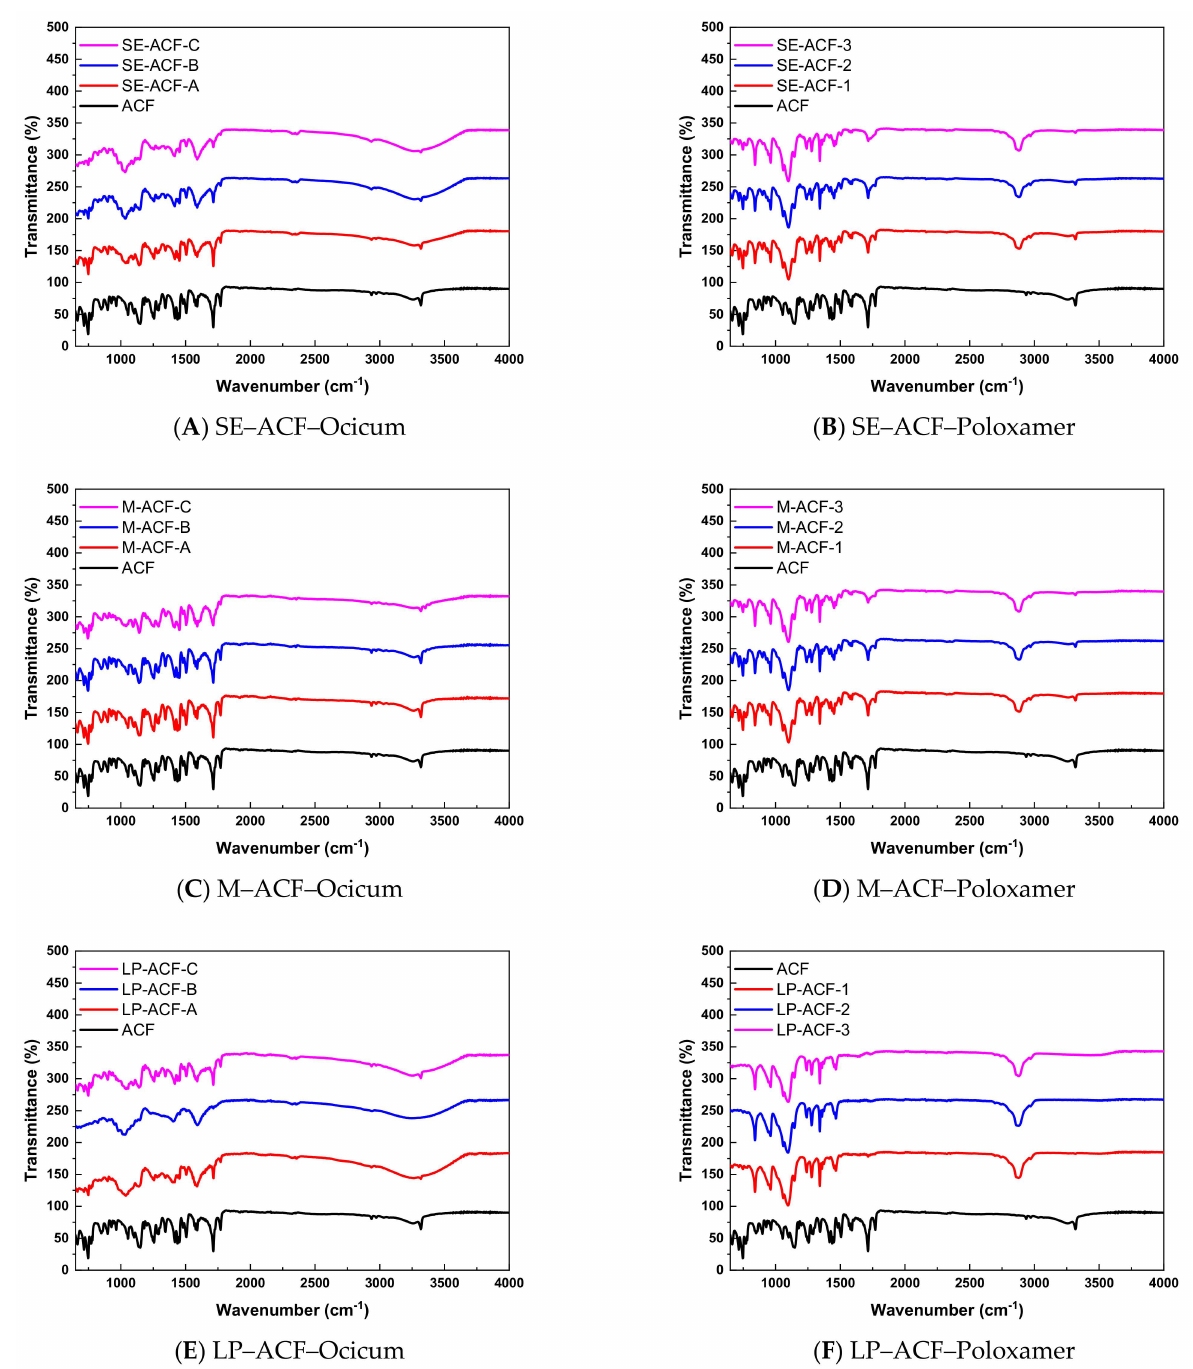
Figure 3. Comparative FTIR analysis of ACF and solid dispersions with Poloxamer or Ocicum in different preparation